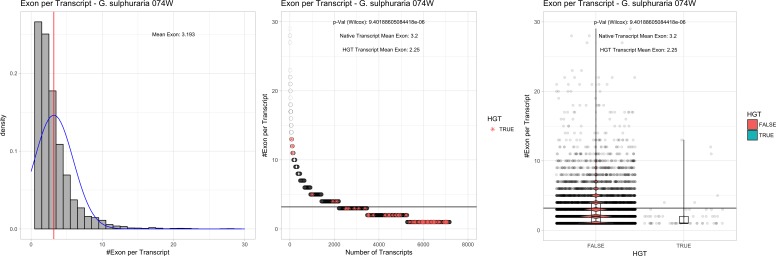
Exon/Intron – Galdieria sulphuraria 074W: (Left) Mid) Cumulative %GC distribution of transcripts.Red line shows the average, blue line a normal distribution based on the average value. The data is categorical (genes have either one, two, three etc. exons) and does not follow a normal distribution. (Mid) Ranking all transcripts based upon their number of exons. Red ‘*' demarks HGT candidates. As the number of exons was not normally distributed, transcripts were ranked by number of exons. In order to resolve the high number of tied ranks (e.g. many transcripts have two exons) a bootstrap was implied by which the rank of transcripts sharing the same number of exons was randomly assigned 1000 times. Wilcoxon-Mann-Whitney-Test applied for the determination of significant rank differences between the native gene and the HGT candidate subset. (Right) Violin plot showing the number of exons per transcript distribution across native transcripts and HGT candidates.